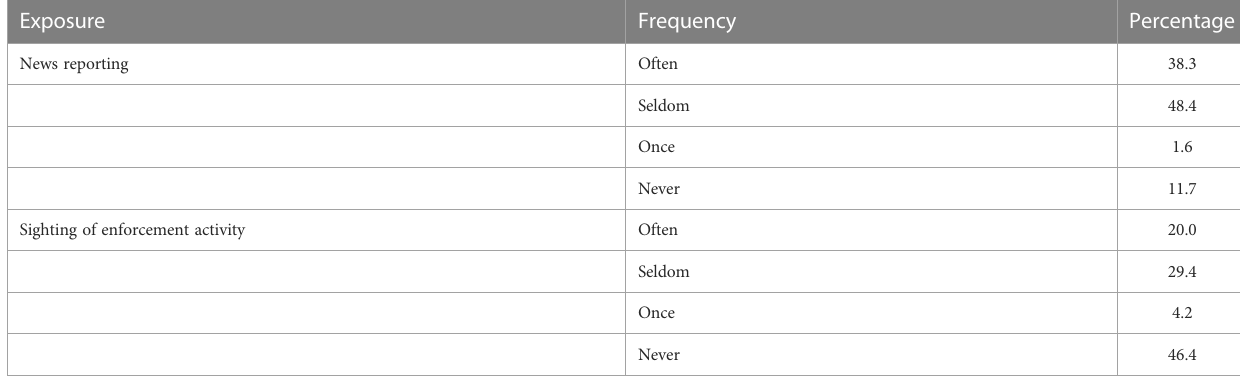
TABLE 2 Percentage distribution of responses for exposure frequency to the Wildlife Protection Law for marine species.